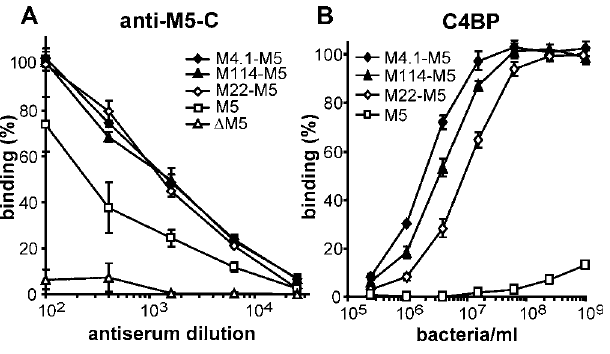
Figure 3. The HVRs of M4.1 and M114 Bind C4BP Fusion proteins, derived from the HVR of M4.1 or M114 and the C- terminal part of M5, were expressed in the M-negative strain S. pyogenes D M5 using genes carried on plasmid pLZ12Spec. Controls included a strain expressing the C4BP-binding fusion protein M22 57 –M5, a strain expressing the non–C4BP-binding M5 protein, and the M-negative strain D M5. (A) Surface expression analyzed with rabbit antibodies directed against the C-repeat region of M5. Bound antibodies were detected with radiolabelled protein A. Binding of protein A to the M22 57 –M5 strain, incubated with antiserum diluted 3 10 2 , was defined as 100%. The M5- negative strain D M5 served as negative control. (B) Binding of radiolabelled C4BP. Binding at the highest bacterial concentration to the control expressing M22 57 –M5 was defined as 100%. The non–C4BP-binding M5 strain served as negative control. All data in (A) and (B) are based on three separate experiments with duplicate samples, and are presented as means 6 SD. DOI: